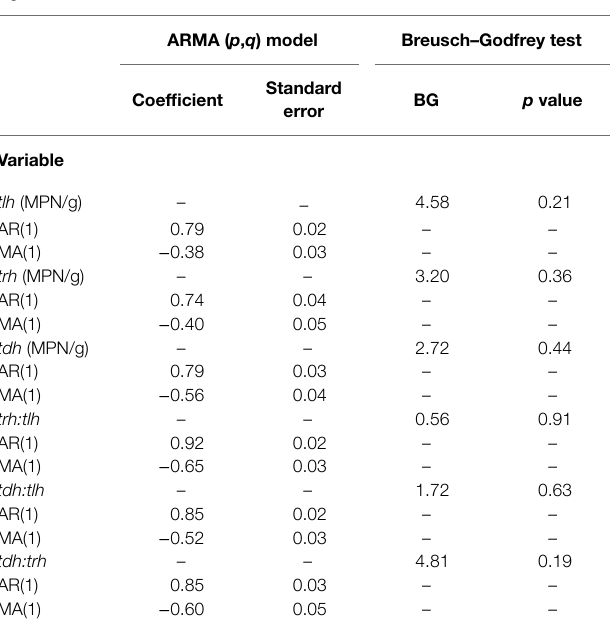
TABLE 5 | Model variable temporal autocorrelation structure and residual